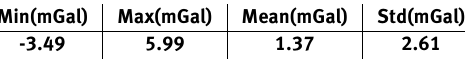
is borrowed from (Safari, et al,